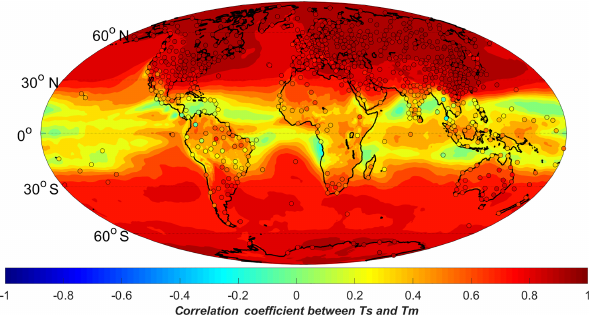
Figure 1. Correlation coefficients between T s and T m generated from radiosonde data (dots) and ERA-Interim reanalysis data sets (color-filled contours) over a period of 4 years from 2009 to